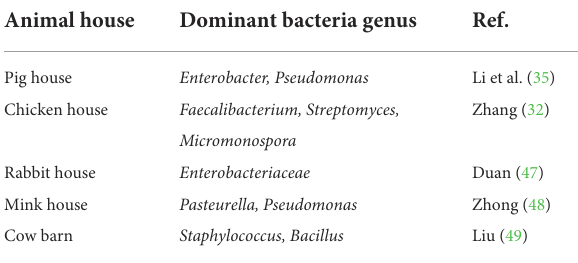
TABLE 1 Dominant bacteria genus in different animal